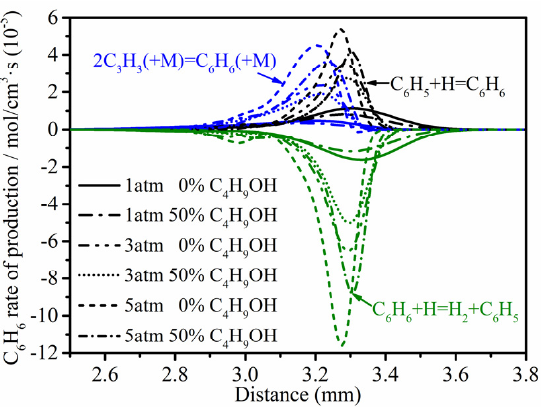
Figure 11. Rate of production of C 6 H 6, with different levels of n -butanol at different pressures.